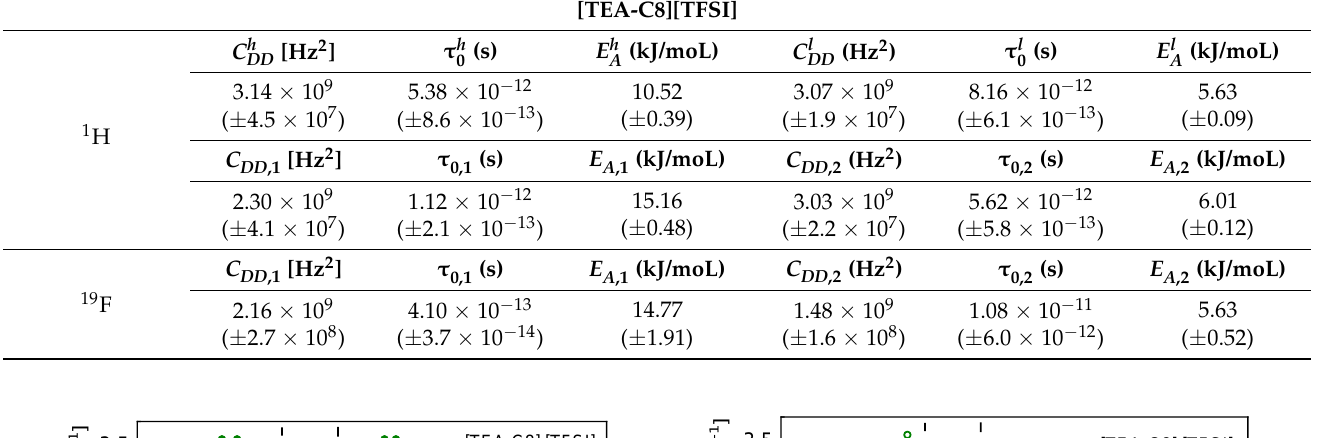
Table 2. Parameters obtained from the analysis of the 1 H and 19 F spin-lattice relaxation data for [TEA-C8][TFSI]. [TEA-C8][TFSI]